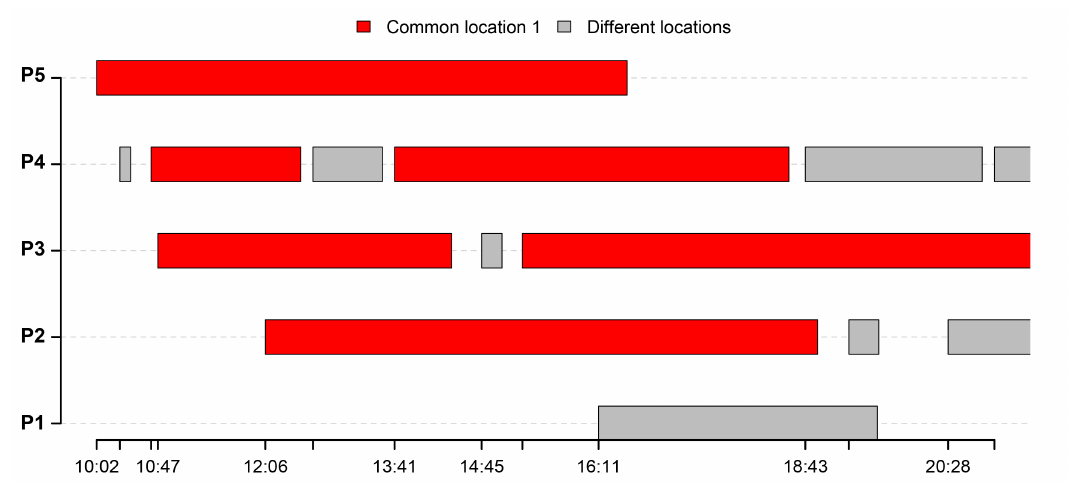
Figure 9. Distance in time between the activities of all of the users for one